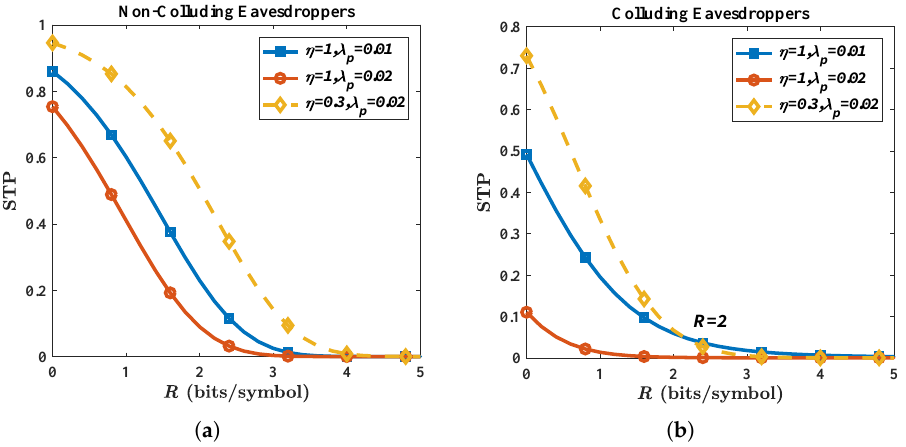
Figure 7. The benefit of AN on STP for ( a ) a non-colluding case; and a ( b ) colluding case. Other parameters are given by: G = 25 dBi, N = 3, f = 300 GHz, P = − 10 dBm, R S = 15 m, η = 0.3. In Figure 8, we find that the optimal η depends on both density λ p and the number of antennas N . For λ p = 0.01 (blue and yellow line), the optimal η in the non-colluding and colluding cases is 0.28 and 0.22, respectively, which are larger than 0.21 and 0.15 for λ p = 0.02. More Eves around PEC signify stronger information attacks. Therefore, Alice must allocate more transmission power to AN to resist the adverse effect of the added Eves. Additionally, the optimal value of η increases with N . As shown in the inset, the optimal η are 0.34 and 0.27 for N = 6 while 0.28 and 0.22 for N = 2. We stress that only Bob benefits from the increase in antennas since the transmitter maximizes the signal strength to Bob and the signal power at Eves’ side remains unchanged.